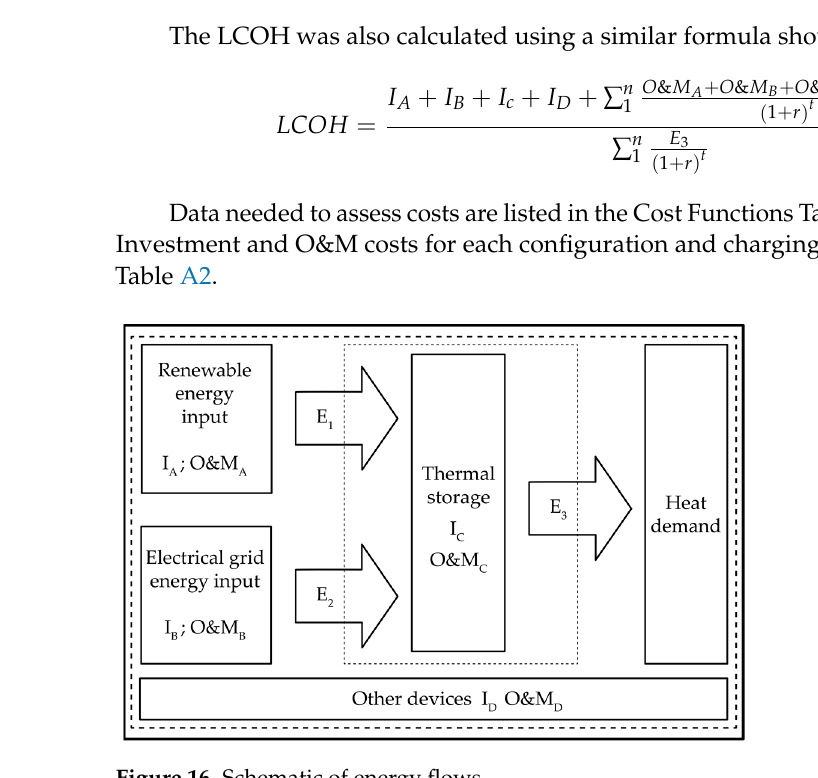
Figure 16. Schematic of energy flows.